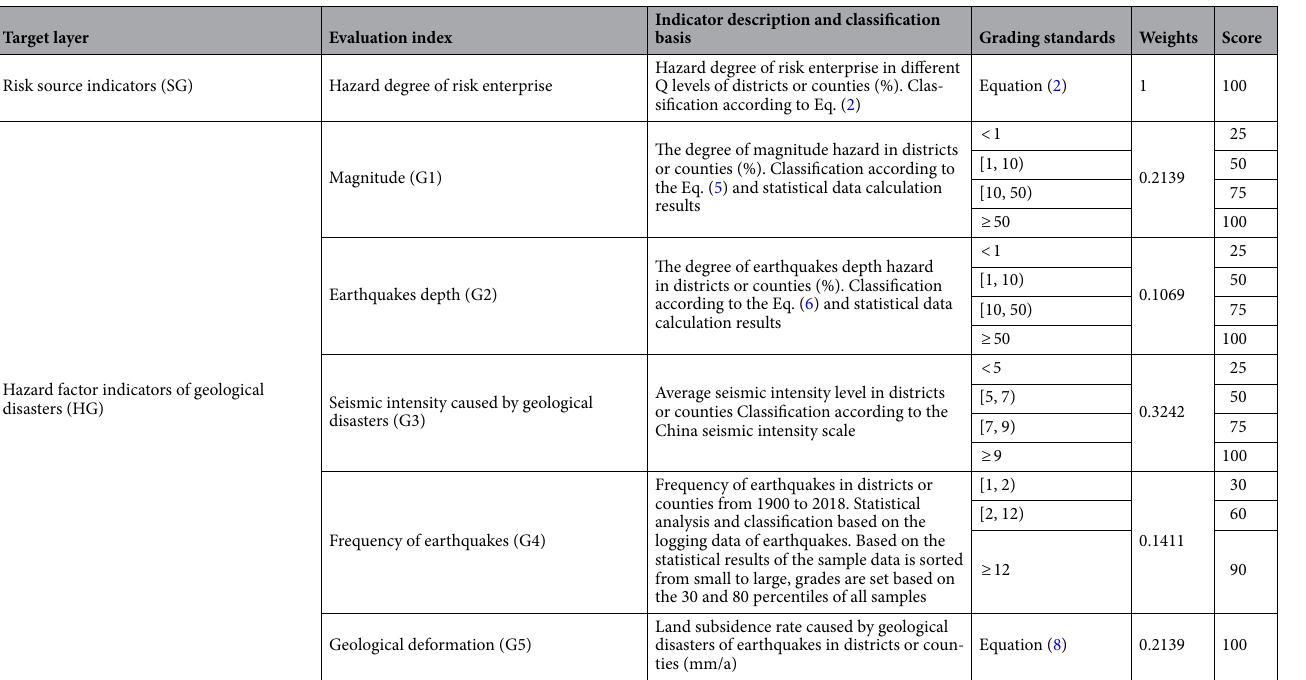
Table 2. The assessment system of Natech risk triggered by geological